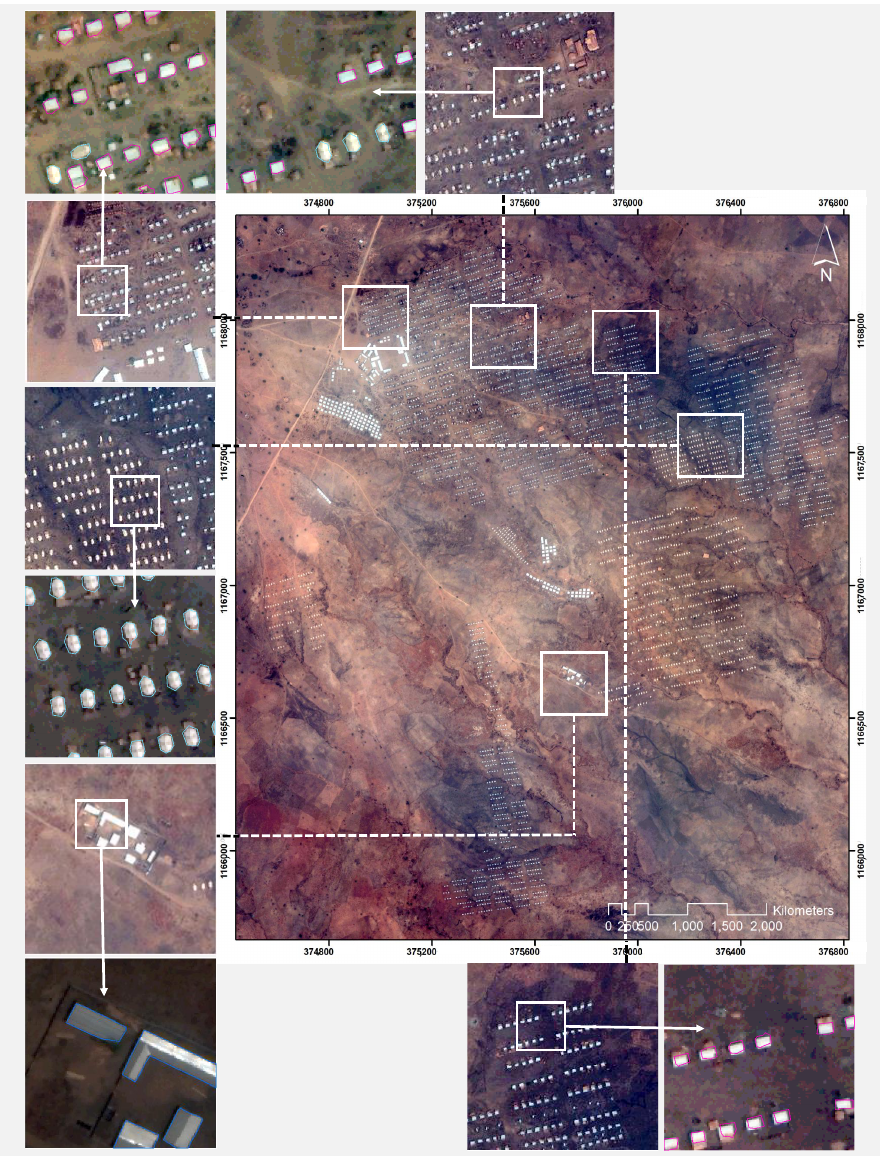
Figure 1. Refugee camp Minawao in the far North region of Cameron. The camp extent on 13 October 2015 and examples on the test set of image patches with ground truth